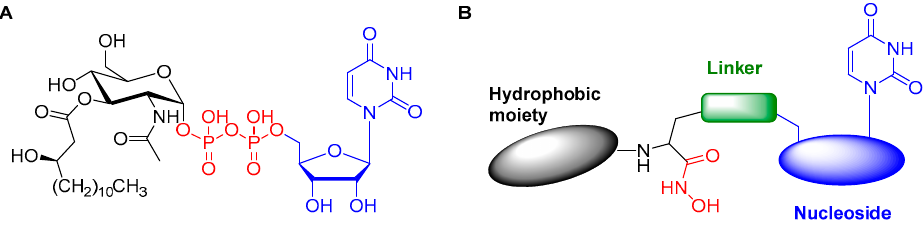
Figure 1. ( A ) The structure of the natural substrate of LpxC; ( B ) General structure of the triazole- linked conjugates.